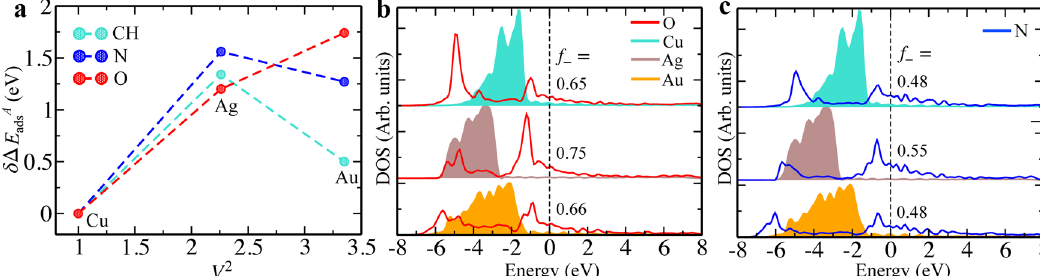
Fig. 2 Chemisorption on pure transition metal surfaces. a DFT calculated adsorption energies of O, N and CH on Cu(111), Ag(111), and Au(111) as a function of the coupling matrix element ( V 2 ). Adsorption energies are shown relative to Cu. The coupling matrix elements are taken from Hammer et al. 1,4 . b , c p -projected density of states for O (red line) and N (blue line), respectively. The d -projected density of states for surface atoms on Cu(111), Ag(111), and Au(111) are shown in turquoise, brown, and yellow, respectively. The fractional fi lling ( f − ) of the resulting antibonding states are shown in each case (for details on how to determine f − , see Supplementary Note 1 and see Supplementary Figs. 1 –